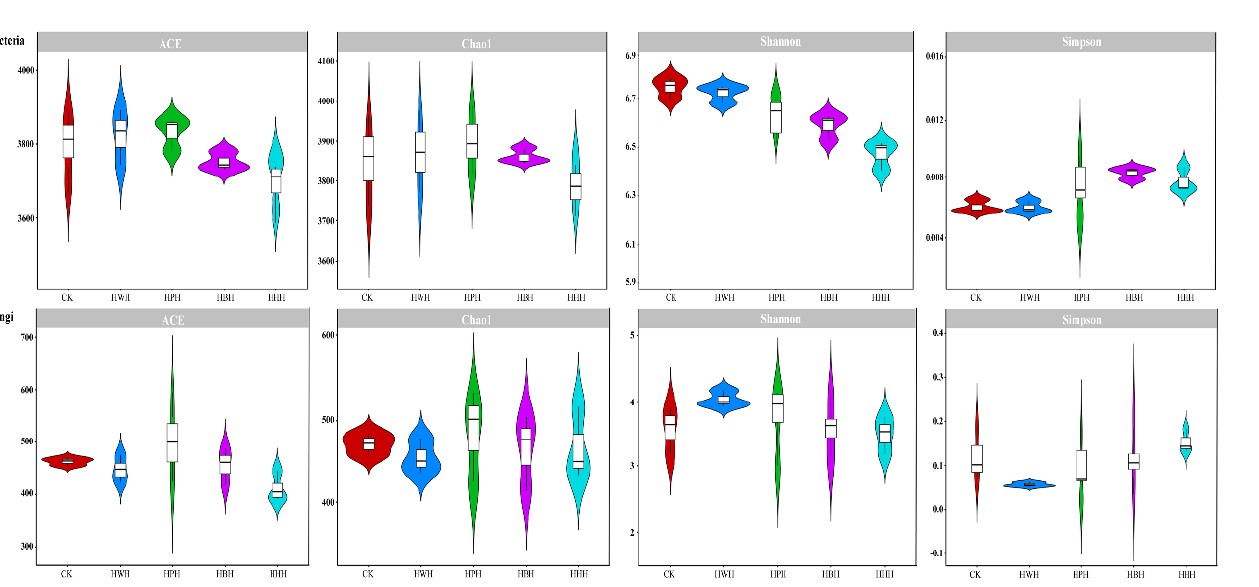
Figure 3. The α − diversity of bacteria and fungi in the rhizosphere of industrial hemp under different cultivation patterns, displayed using with violin plots. The black line running through the violin diagram up and down represents the interval from min to max, 95% confidence interval. The lower end of the line represents the upper and lower limit, and the data beyond this range is abnormal.